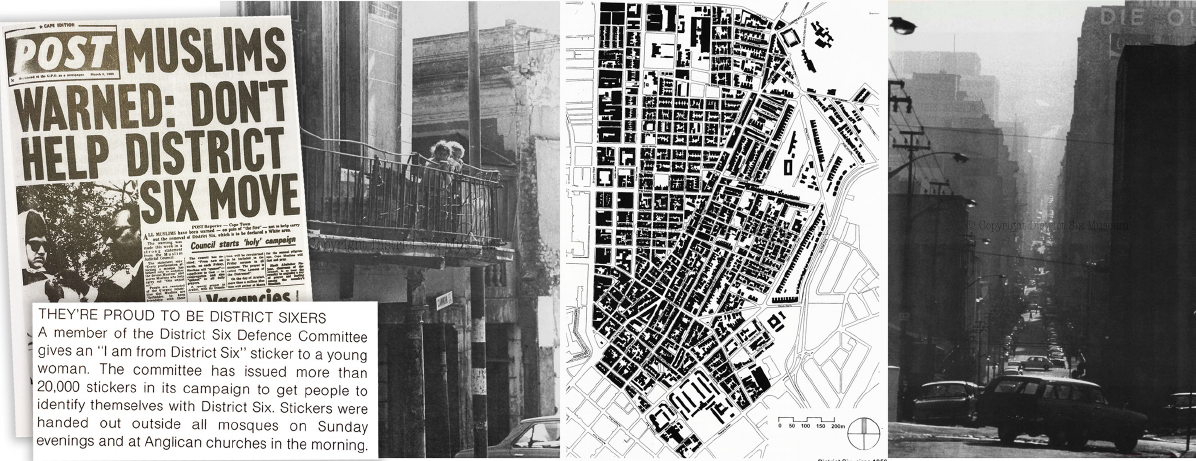
Figure 4. Example extract from an international case study (Stage 2a in Figure 2) of District Six, Cape Town. The dis‐ trict was one of the most historic and most architecturally impressive, as well as one of the most ethnically and racially diverse in the city, understood as “cosmopolitan, socially harmonious, culturally hybrid and heterogeneous” (Soudien, 2001, pp. 119–125), yet apartheid policy was the basis for forced relocation and demolition. District Six and its citizens became a symbol of diversity in the face of apartheid: “The razing of District Six in the late 1970s was a high‐handed and dismissive act, the results of which were unbelievably cruel. In many ways its destruction is for us a local example not only of the wilful annihilation of an urban community but also of the loss of urban place, so much lamented by sociologists and urban planners” (Le Grange, 1996, p. 7). Source: Photos and maps from Greshoff and District Six Museum